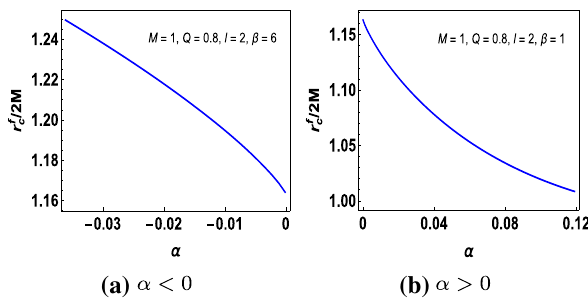
Fig. 7 The Gibb’s free energy a for some parameter choices and b for the BI charged and Maxwell charged solutions in the novel 4D EGB gravity and GR